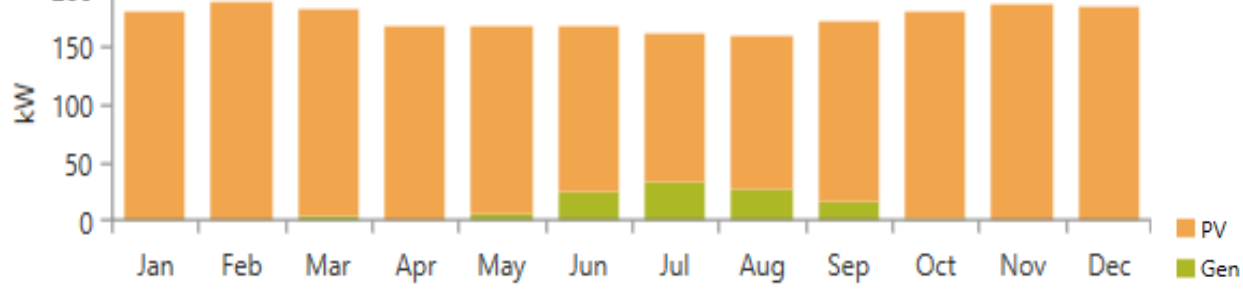
Table 5. Comparison of first rank of feasible system with base case (DG).